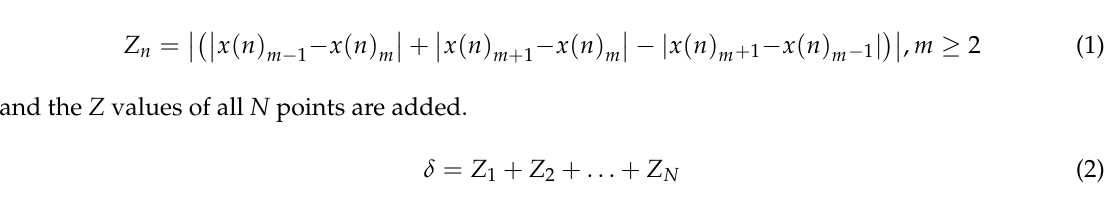
Figure 12. Prototype of an AFDD.